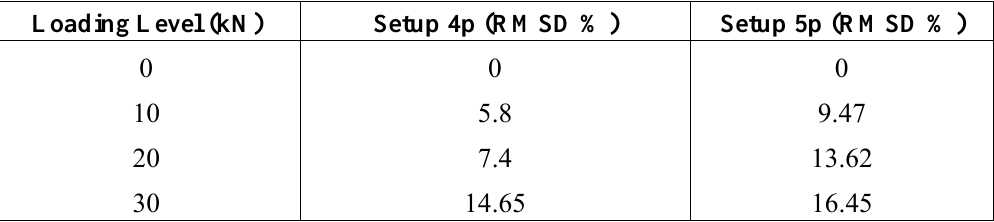
Table 3. RMSD values of two reusable PZT setups.